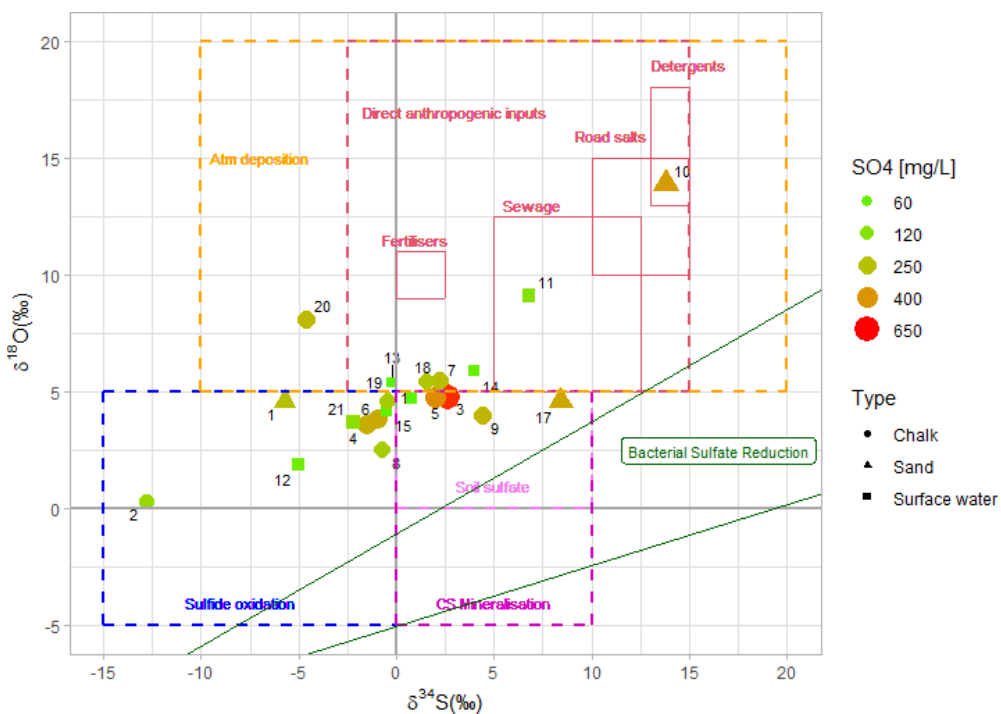
Figure 5. Stable isotopes of sulphate ( δ 34 S ± 0 . 4‰ and δ 18 O ± 0 . 6‰): results of the Boussu site for Summer 2021(the first campign in which those analysis where